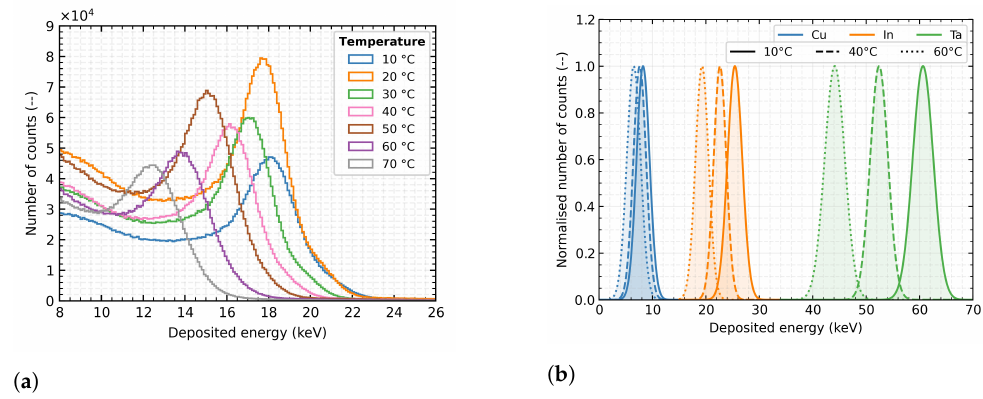
Figure 4. The thermal influence on energy measurement. ( a ) the set of spectral measurements depends on the detector temperature from 10°C to 70°C for constant settings of the X-ray tube with the Molybdenum XRF target; ( b ) visualisation of the temperature effect on the measured incident radiation energy. Normalised Gaussian curves represent the individual spectral peaks for better clarity. The detector was calibrated for 20°C.